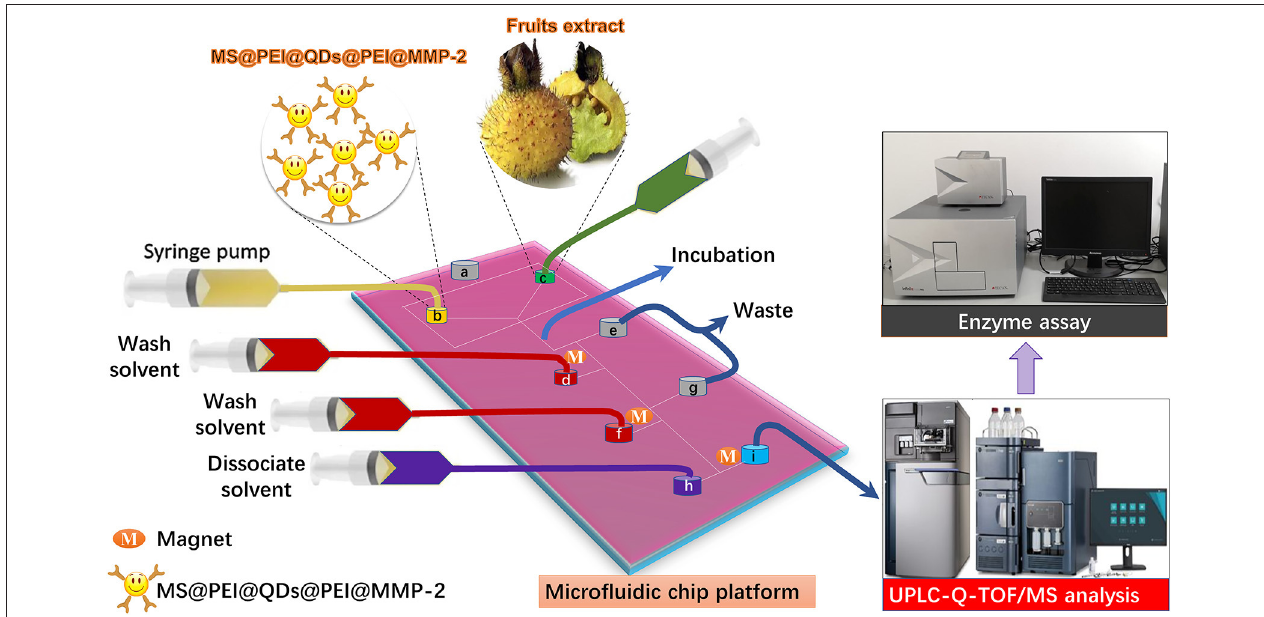
FIGURE 1 | Schematic of microfluidic chips-based matrix metalloproteinases inhibitors recognition system. MS@PEI@QDs@PEI@MMP-2 and extract of Rosa roxburghii were infused into the channel of the microfluidic chip and incubated for a period. Then, unspecific binding compounds were washed to the waste by